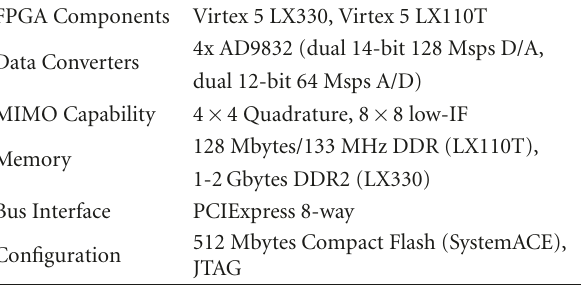
Figure 1: The CBMIMO1 board.